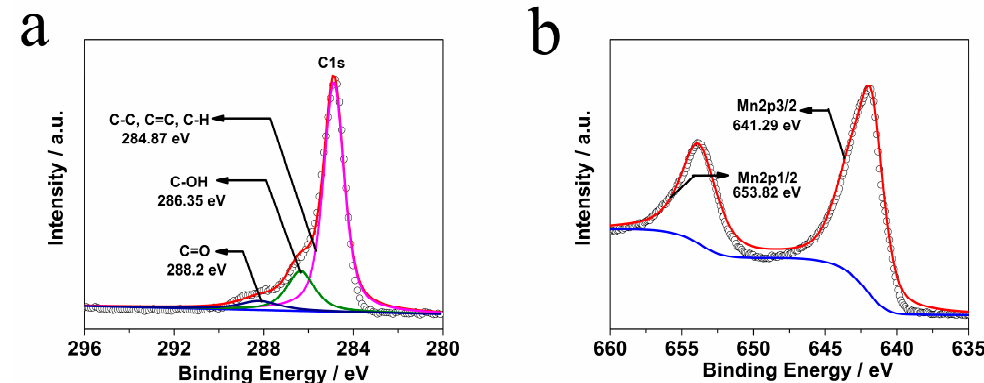
Figure 4. ( a ) C 1s XPS (X ‐ ray photoelectron spectroscopy) of MnPO 4 ∙ H 2 O nanowire/GO composite material; ( b ) Mn 2p 3/2 and 2p 1/2 spectra in this material.